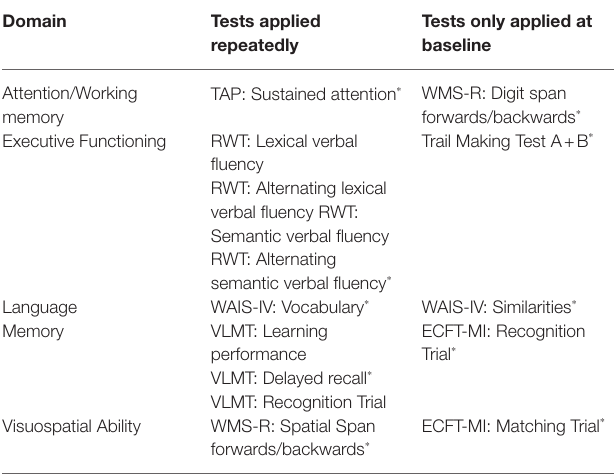
TABLE 1 | Overview of applied neuropsychological tests.